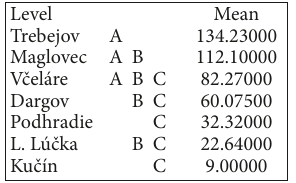
Figure 9: Means comparisons L < 0; 40 > v